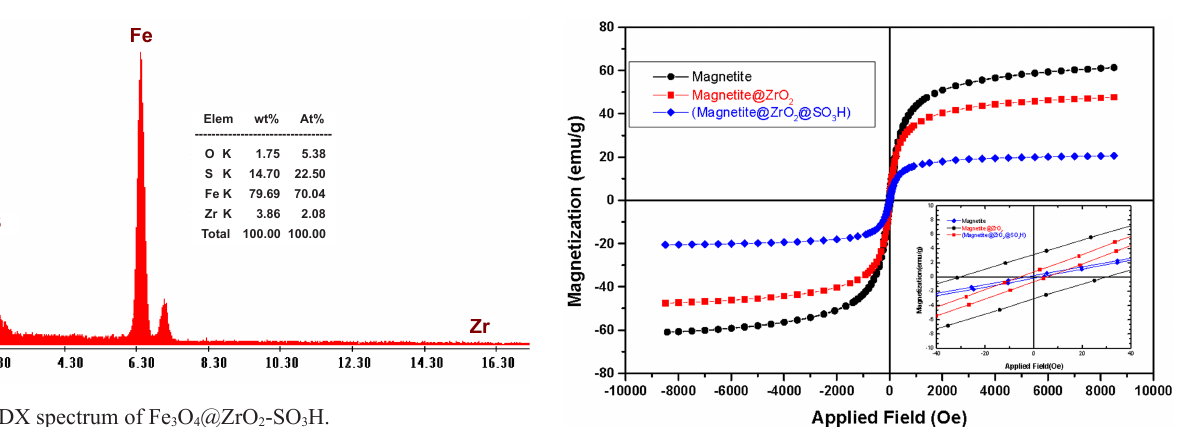
Fig. 5. EDX spectrum of Fe 3 O 4 @ZrO 2 -SO 3 H.